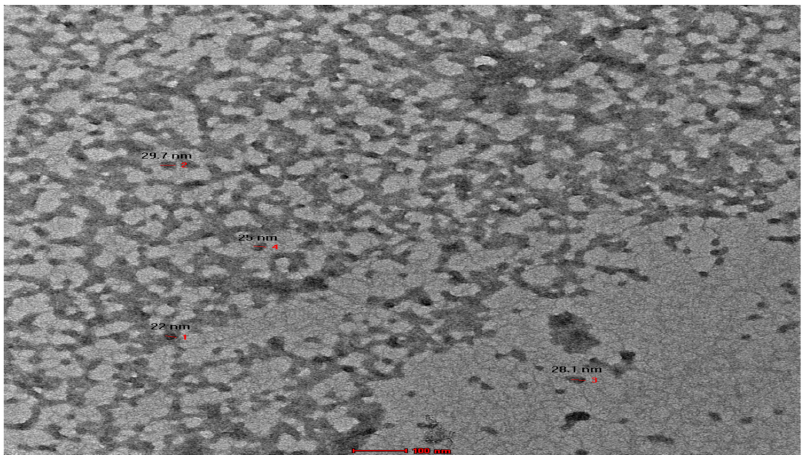
Figure 3. (TEM image of CS–urea